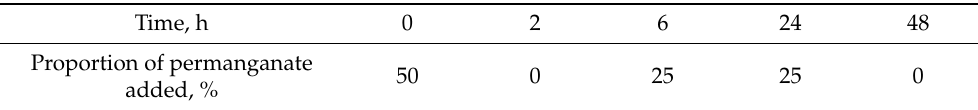
Table 2. Proportion of permanganate added during the experiments with adding permanganate in multiple stages.